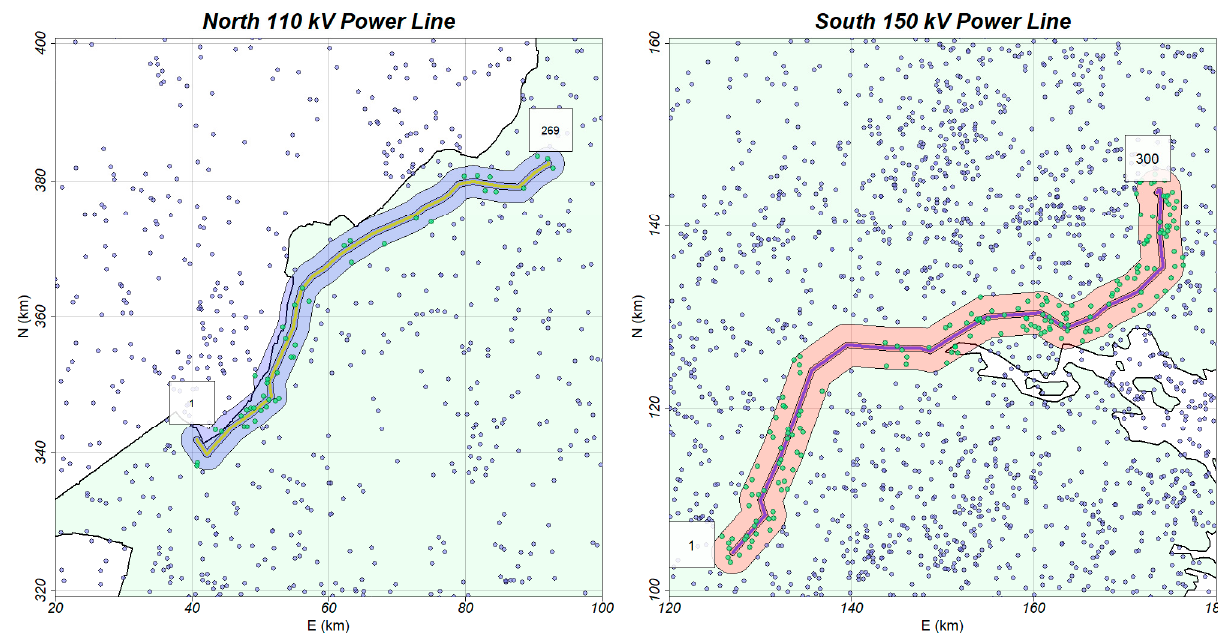
Figure 4. The distribution of flashes near the transmission line and inside its buffer area. The “North” power line is shown on the left, and the “South” power line is shown on the right. The first and last supports of the overhead line are also marked on the map.